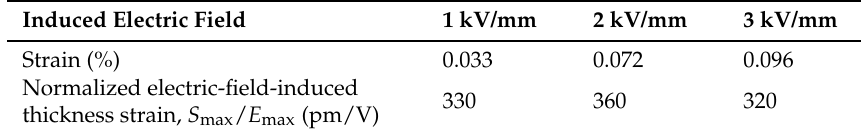
Table 3. Strains and S max / E max of multilayer KNN-CZ-2 sample (measured temperature: 25 ˝